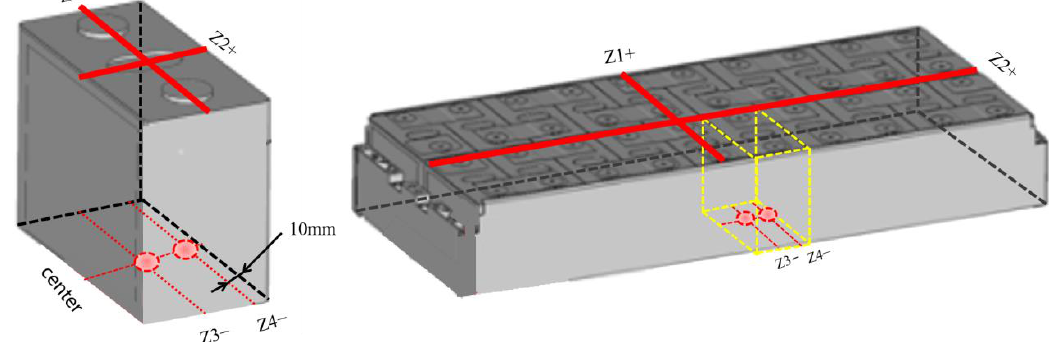
Figure 3. Impact position of the cell and